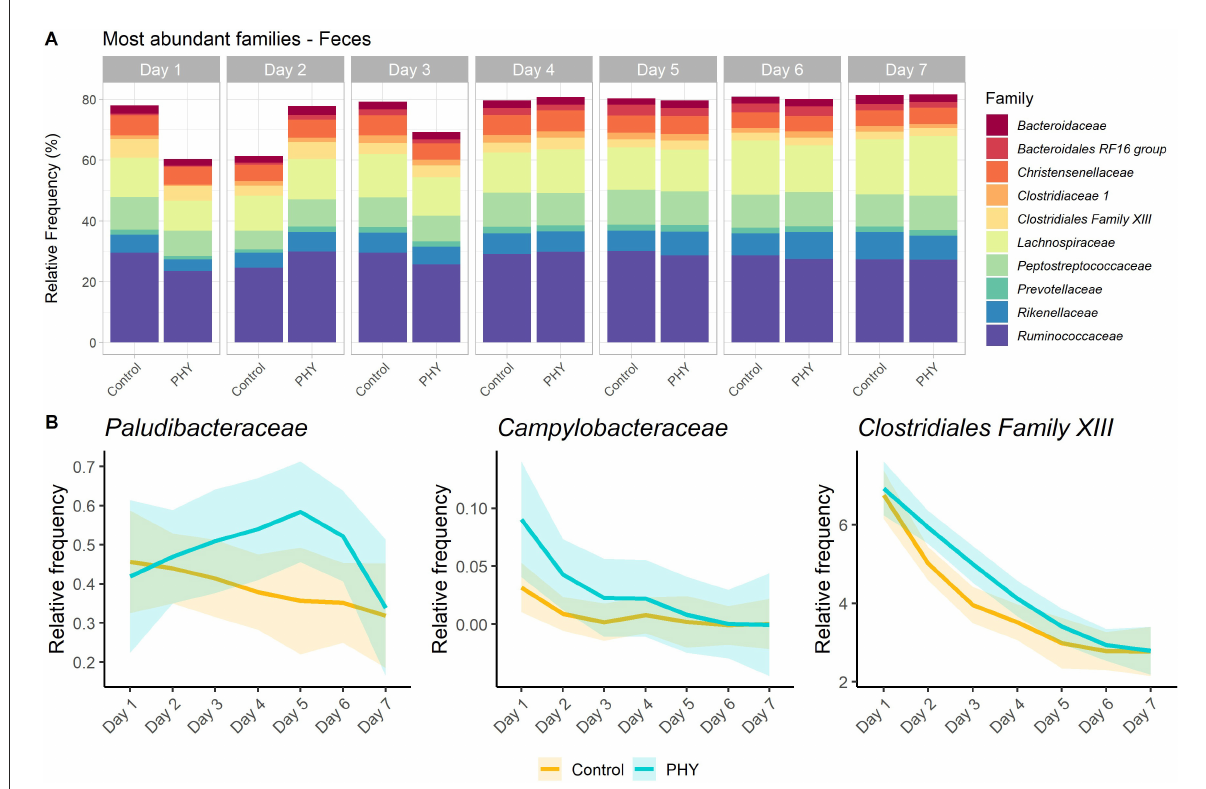
FIGURE4 Microbiota composition of the fecal samples. (A) Barplot showing the mean relative frequency of the 10 most abundant families (across all samples) over the experimental days and between the two experimental groups (PHY and control). (B) Plots showing the different relative frequency trends over the experimental days between the treatment (PHY) and control group. The PHY increased the relative abundance of Paludibacteriaceae ( P = 0.06), Campylobacteraceae ( P = 0.09) and Clostridiales Family XIII ( P =